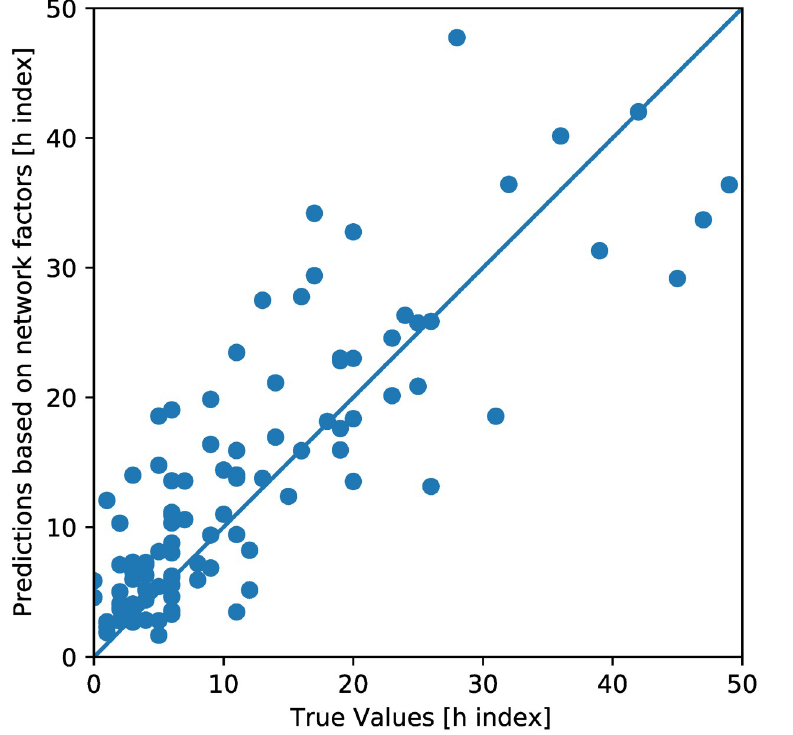
Fig 4. True and predicted values for H-Index. Predictions up to an H-Index of 50 are